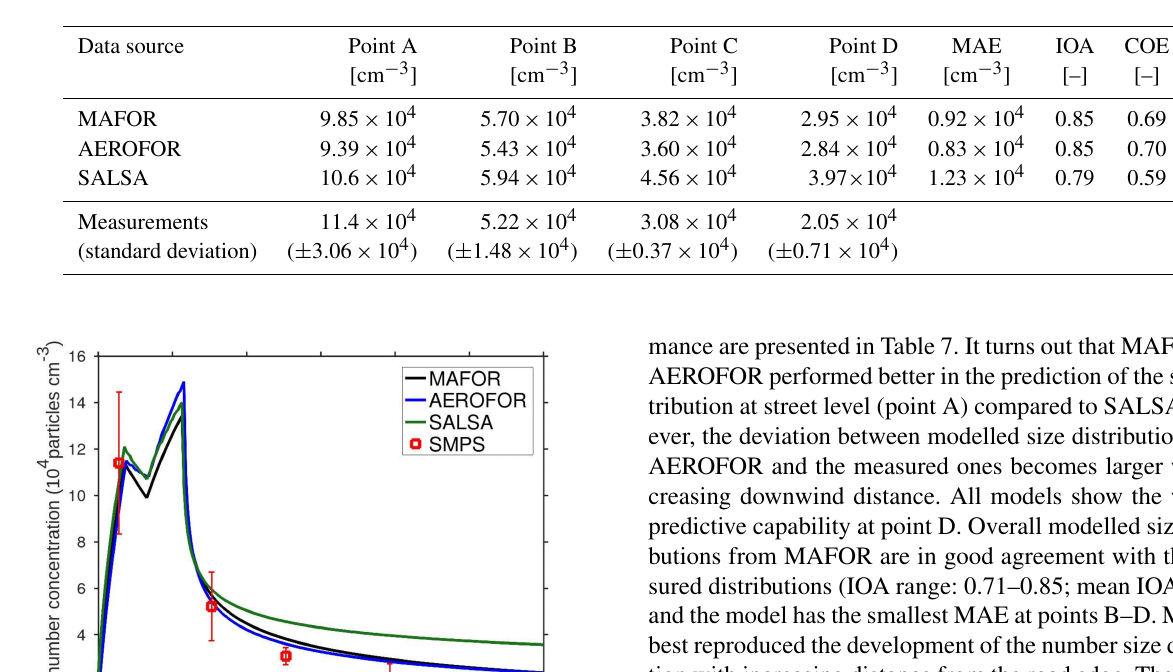
Table 6. Comparison of modelled total number concentration from different aerosol dynamics models and measured data together with statistical indicators. Standard deviations of measurements are given in round brackets.